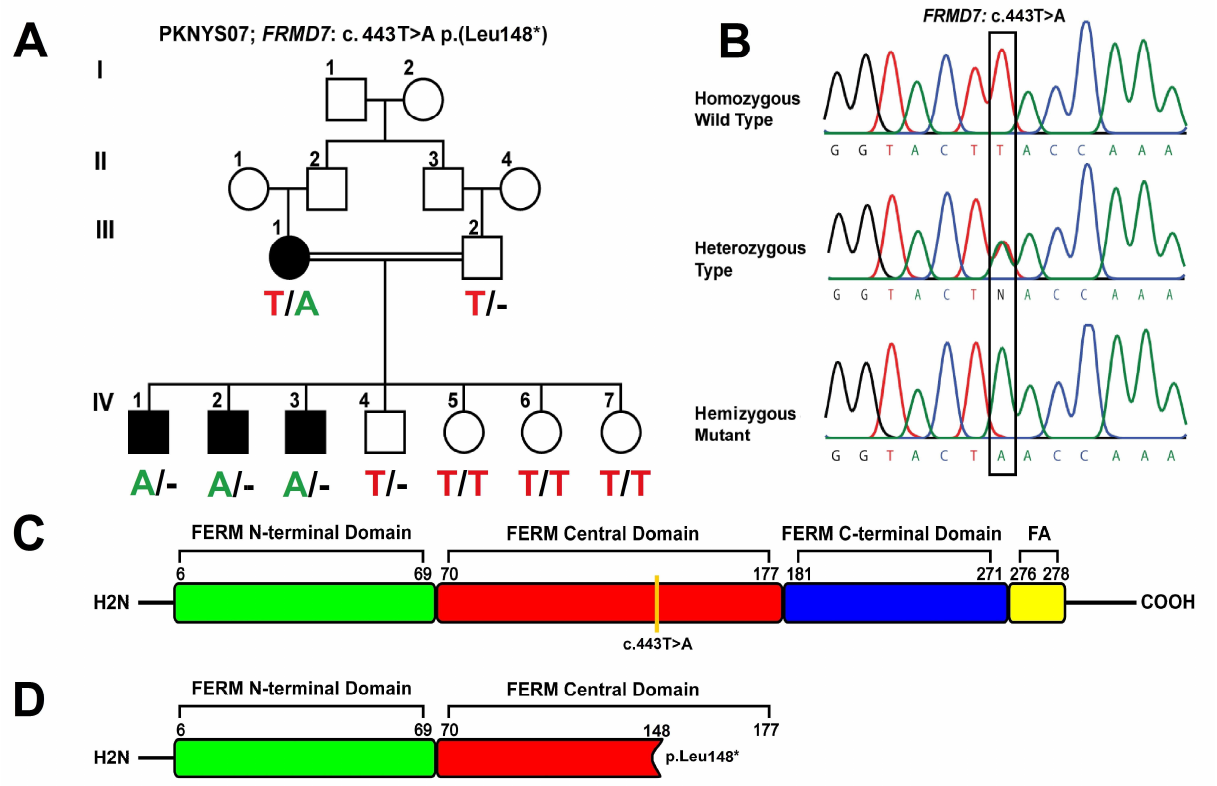
Figure 1. Genetic analysis of family PKNYS07 having X-linked pattern of inheritance. ( A ) Co- segregation analysis of affected, mutated, and normal individuals of PKNYS07 showing all affected males are hemizygous for c.443T>A mutation; ( B ) From top to bottom chromatograms of wildtype, heterozygous type, and hemizygous mutant individuals at position c.443; normal person presenting the base A (Top); at position c.443 heterozygous person chromatogram presenting overlapping of A/T at the base (Centre); position and mutant person’s chromatogram presenting the substitution of T>A at the same position (Bottom); ( C ) variant position concerning domain architecture of the protein. Normal FRMD7 protein structure [15,16] consists of FERM-N terminal domain from 6–69 residues (green colour), FERM -central domain (red colour) from 70–177, FERM-C terminal (blue colour) from 181–271, and FERM -adjacent (FA) (yellow colour) from 276–278 residues. ( D ) represent mutated FRMD7 structure showing stop codon at position p. Leu148 * .